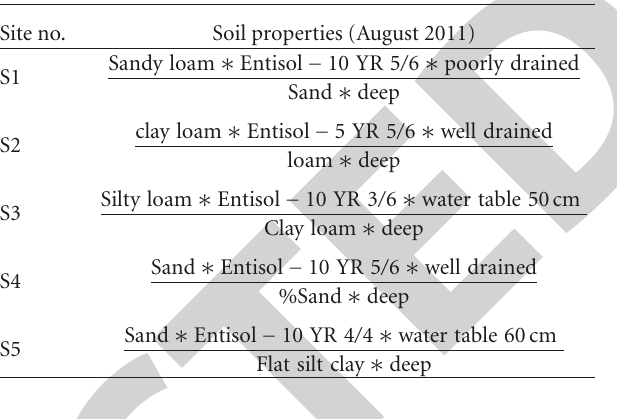
Table 1: Morphological properties of the soil of Bestari Jaya catch-